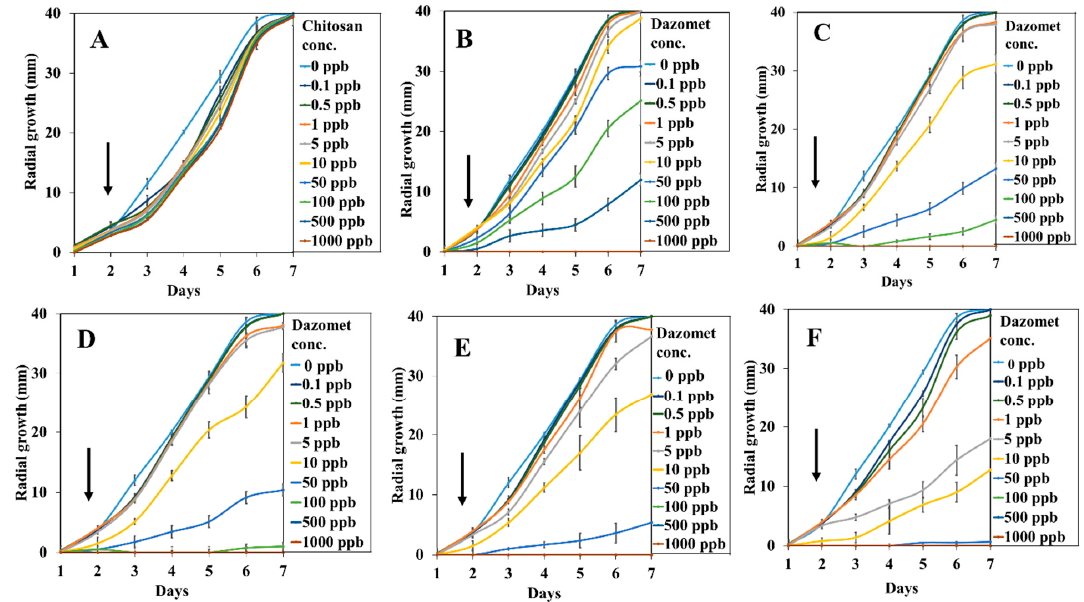
Figure 8. Growth curve of G. boninense from day 1 to 7 incubated in ( A ) chitosan, ( B ) pure dazomet, and chitosan-dazomet nanoparticles at various concentrations of TPP: ( C ) 2.5, ( D ) 5, ( E ) 10, and ( F ) 20 mg/L incubation at 28 ± 2 °C. Black arrows represent the increasing of the dazomet concentration.